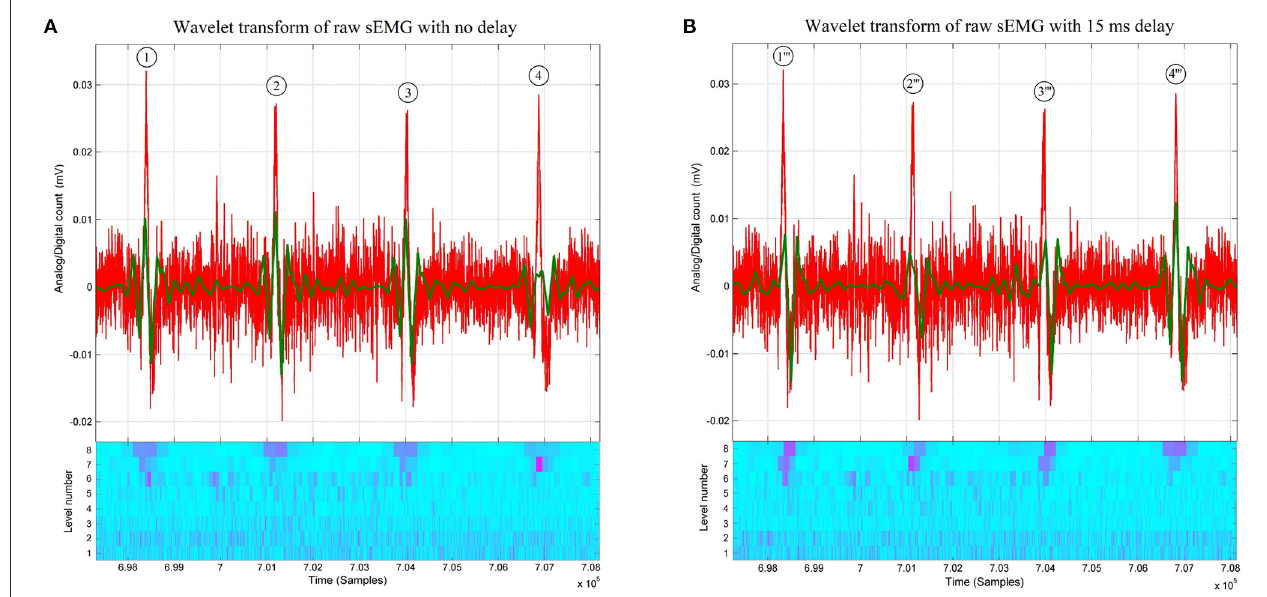
FIGURE 2 | (A) Raw thoracic surface electromyographic signal (in red) of control subject #4, overlaid with its 8-level wavelet transformed sub-signal (in green) and its scalogram below (Conventions are the same as in Figure 1 ) . Note that at the first, second, and third bursts the matching between the raw sEMG signal and its 8-level sub-signal is better than the one at the fourth burst. The recovery of the matching between the fourth burst and its D8 doublet is shown in Figure 3 , where different time delays are applied before wavelet processing. (B) Raw thoracic surface electromyographic signal (in red) of subject #4 (control) time-shifted by 15 ms (in red), overlaid with its 8-level wavelet transformed sub-signal (in green) and its scalogram below (Conventions are the same as in Figure 1 ) . A time shift of 15 ms (skipping the first 60 samples) on the raw signal before wavelet processing is sufficient for the fourth D8 doublet to better match the raw sEMG signal than when no time shift is applied to the raw signal as in (A)